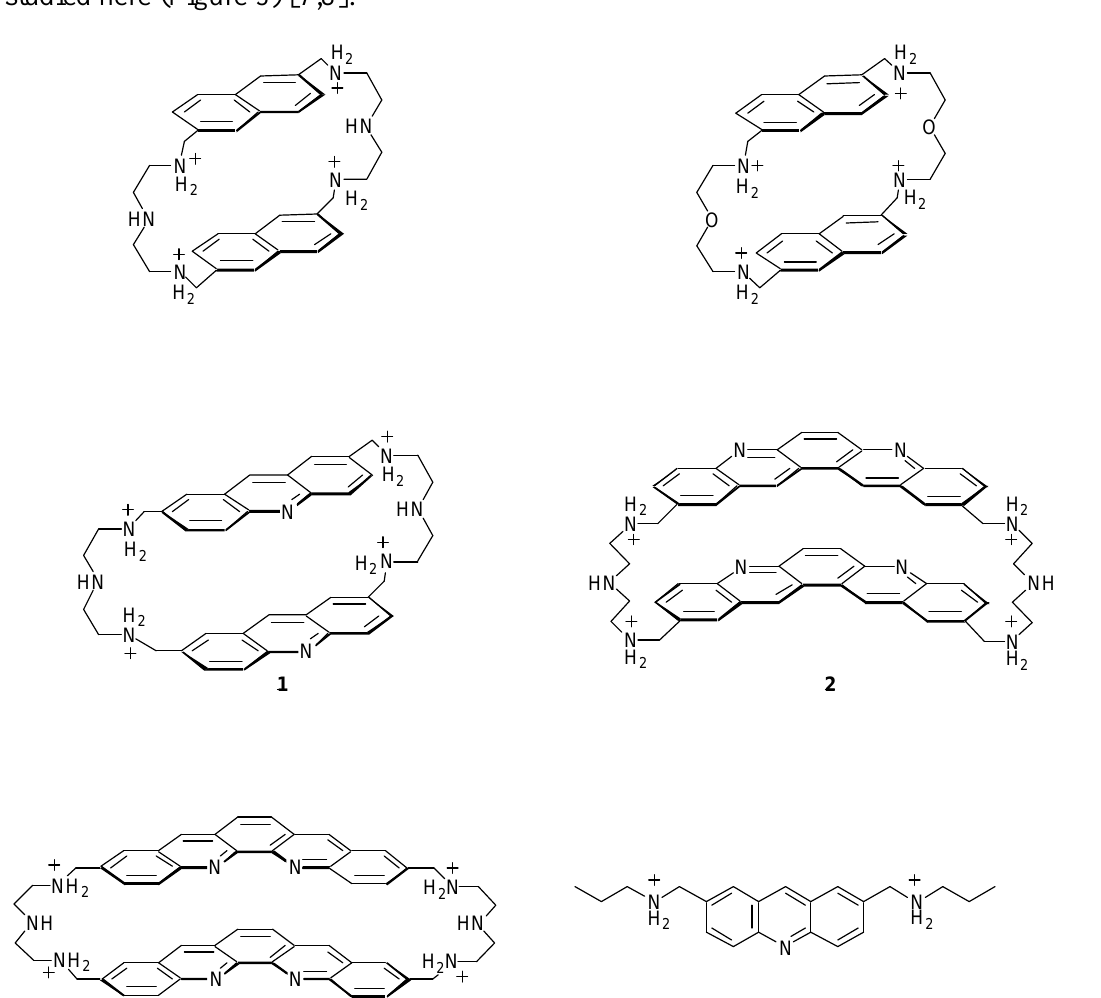
Figure 3. Representative polyamino cyclobisintercalands and the acridine monomer